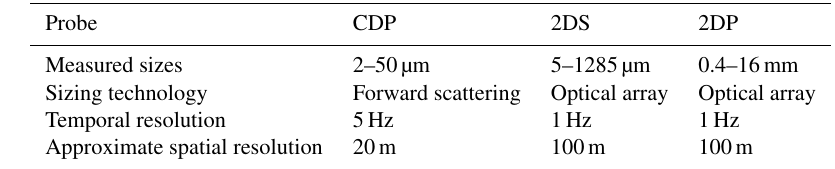
Table 1. Cloud microphysics probe sizing and technology.